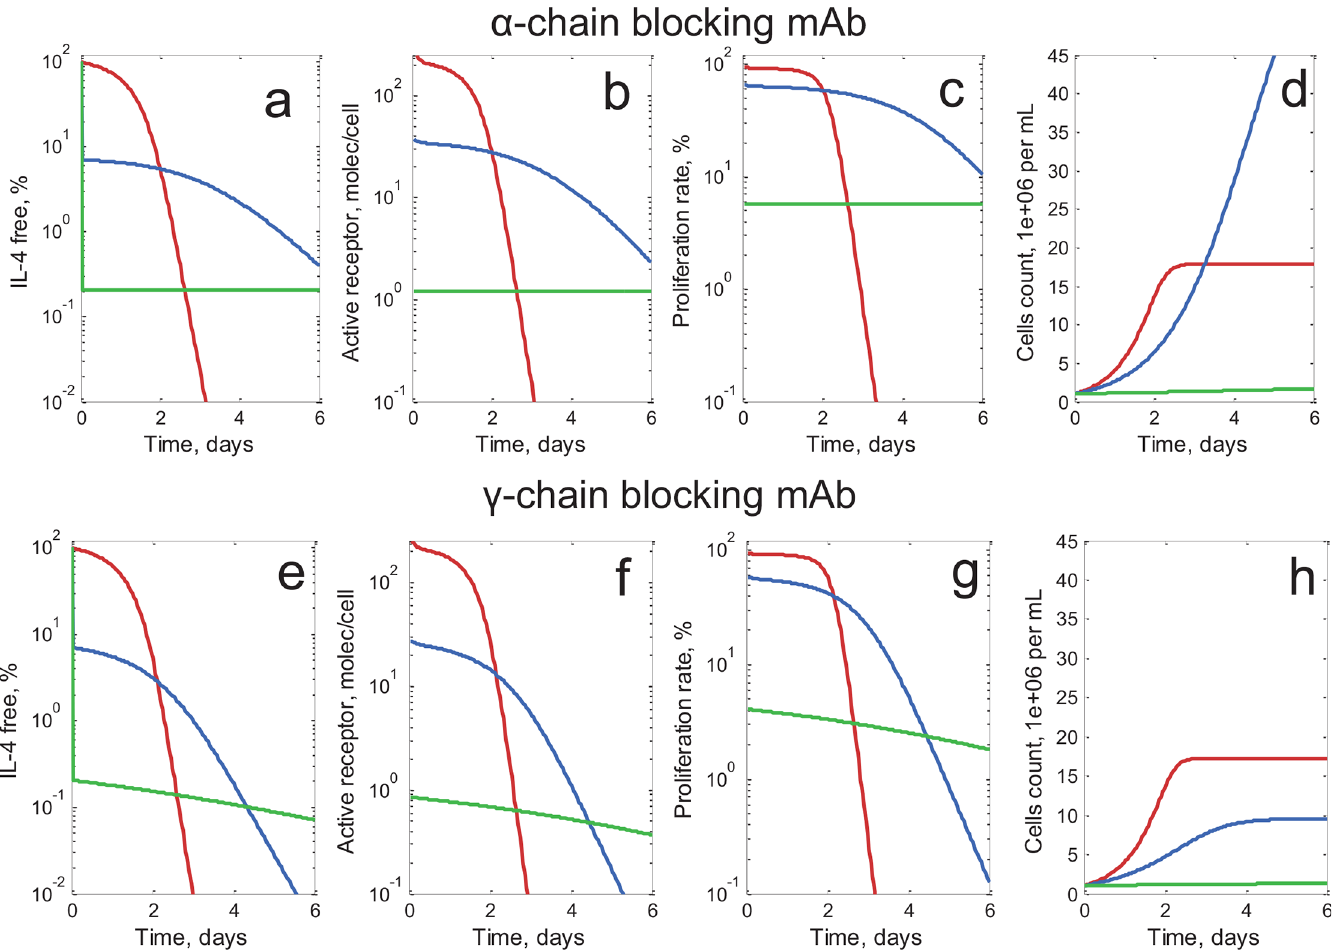
Fig 3. Kinetics of free interleukin, signaling, proliferation rate and cell count. In the model, T cells were incubated with IL-4 250 pM and different concentrations of mAb (5 pM — red lines, 250 pM – blue lines, 10000 pM – green lines; mAb K D set at 20 pM) during 6 days. (a, e) Time course of free IL-4 (100% represents the initial IL-4 concentration of 250 pM); (b, f) Time course of number of the signaling complexes per cell; (c, g) Proliferation rates, expressed as an Emax function of the number of signaling complexes, with EC 50 = 20 signaling complexes per cell; (d, h) Time course of cellular proliferation, expressed as T-cell count. The initial number of T cells is 1 x 10 6 per